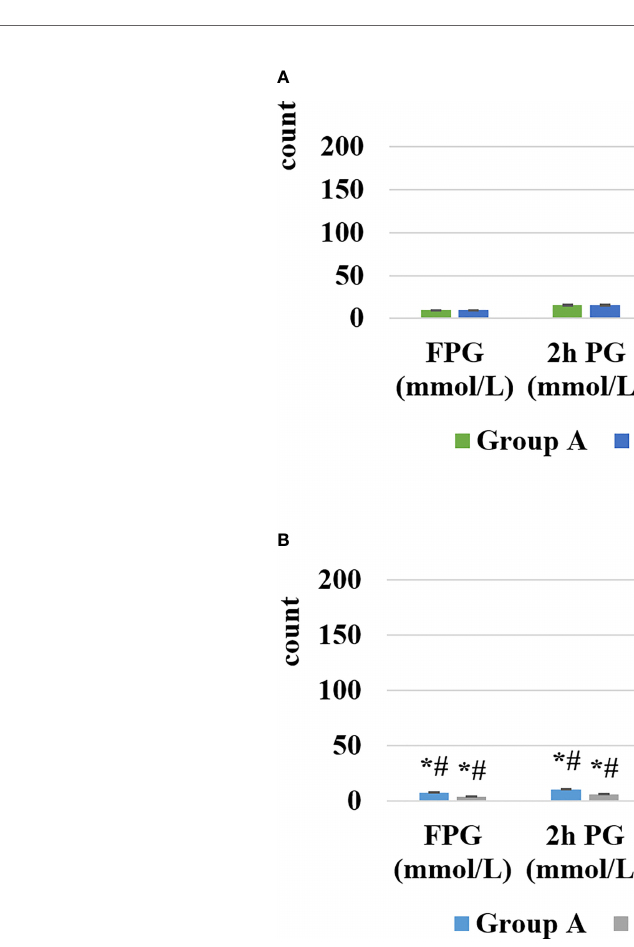
FIGURE 3 | Comparison of blood glucose and blood pressure before and after nursing [ (A) showed the change before nursing, (B) showed the change after nursing; *# represented the comparison with the case in the same group before nursing, the difference was statistically signi fi cant (P < 0.05)].